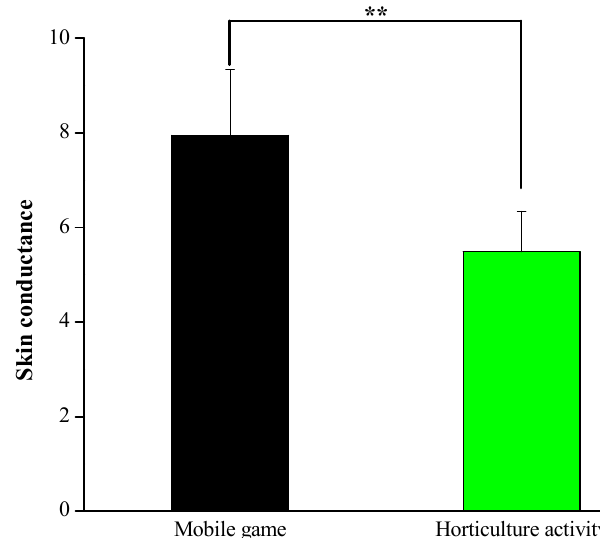
Figure 4. Mean of skin conductance during the 5 min experimental period; n = 26, mean ± SE, ** p < 0.01 determined by the paired t -test.